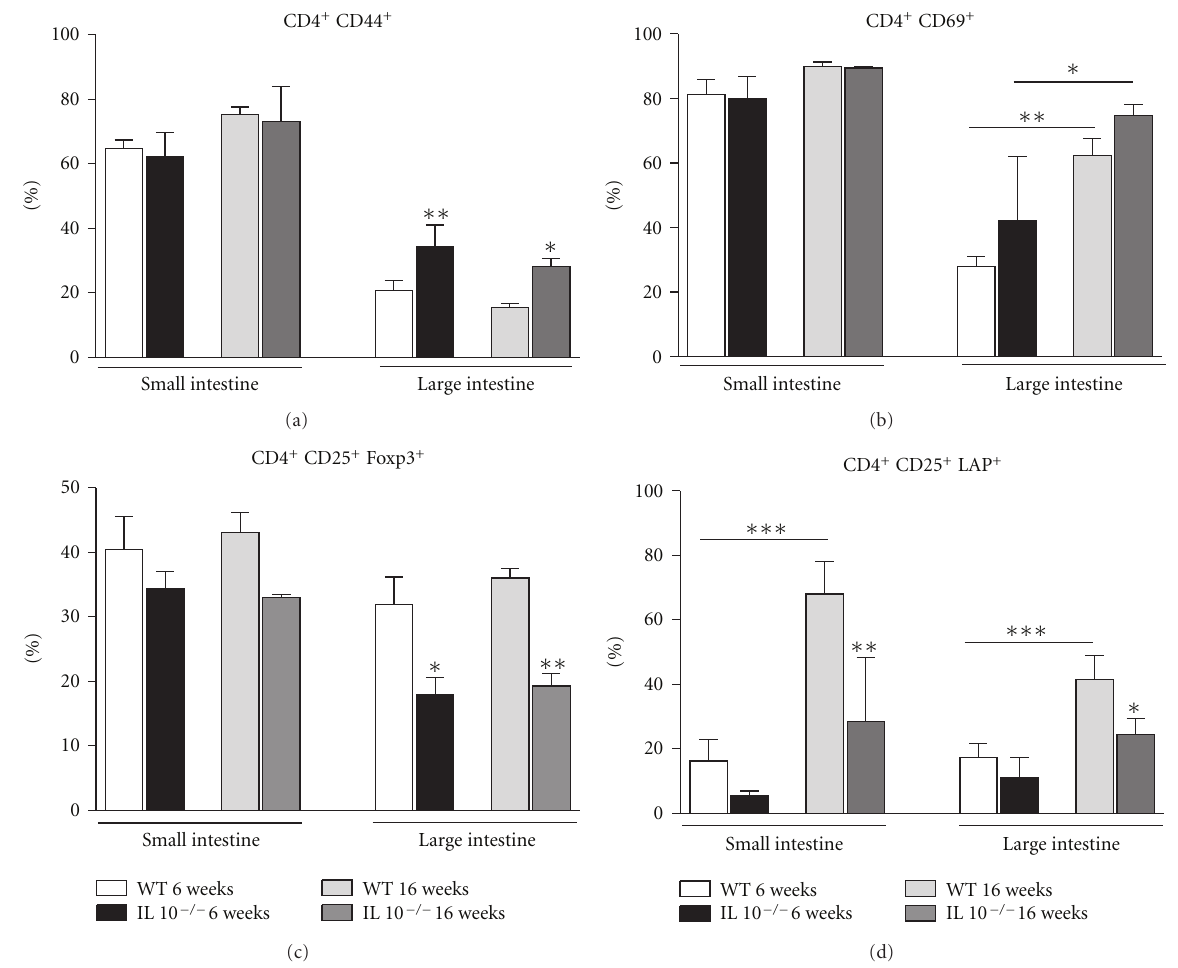
Figure 3: T lymphocyte profile in the lamina propria of small and large intestine of IL-10 − / − mice during the course of intestinal inflammation. Lamina propria T cells from small and large intestine were obtained from either 6- or 16-week-old IL-10 − / − mice. Age- matched 129Sv/Ev (WT) mice were used as controls. Frequencies of CD4 + CD44 + (a), CD4 + CD69 + (b), CD4 + CD25 + Foxp3 + (c), and CD4 + CD25 + LAP + (d) T cells gated in CD4 + T cells were assessed by flow cytometry. Bars represent the mean ± SEM of 4 mice per group. Significant di ff erences ( ∗ P < 0 . 05, ∗∗ P < 0 . 01 or ∗∗∗ P < 0 . 001) are indicated by